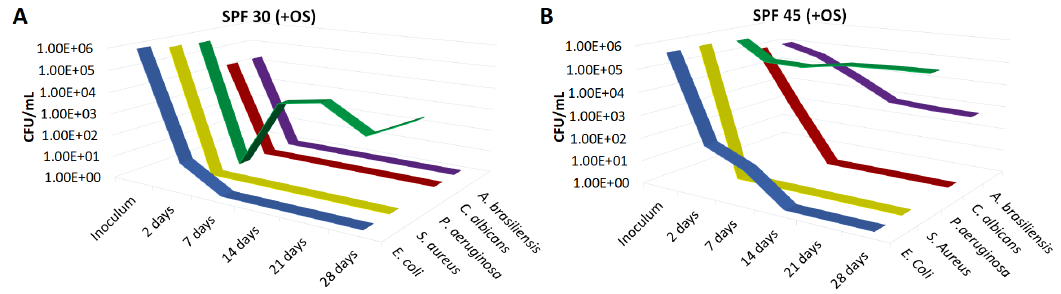
Figure 2. Challenge tests of typical sunscreen formulations against five pharmacopeia strains. Two different sunscreen formulations with SPF 30 ( A ) and SPF 45 ( B ), were challenged separately with 1 × 10 6 CFU/mL of E. coli , S. aureus, and P. aeruginosa , and 1 × 10 5 CFU/mL of C. albicans and A. brasiliensis .